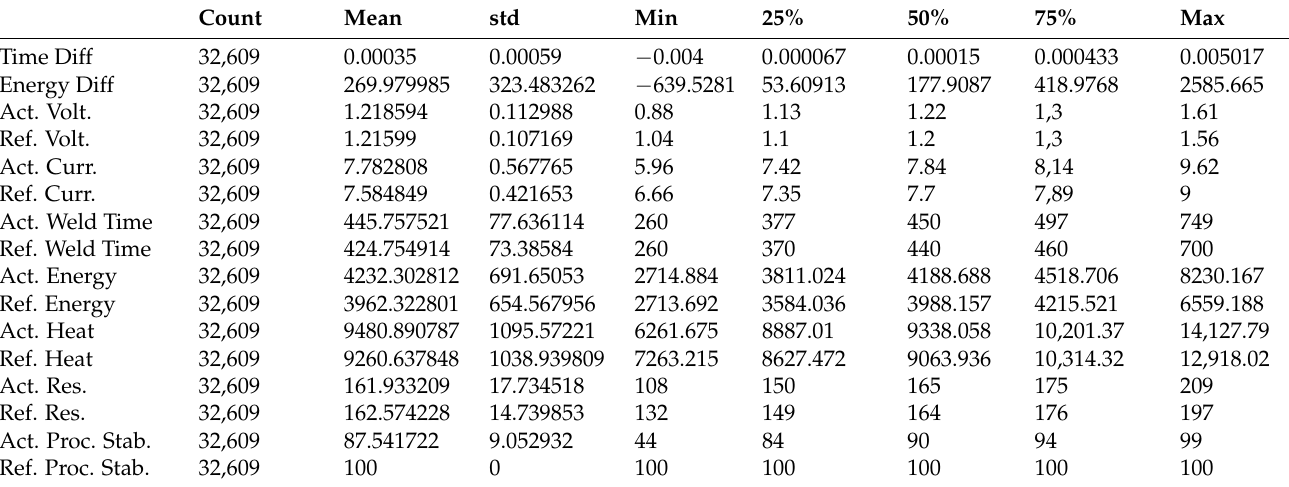
Table 4. Summary of numerical variables in data set.